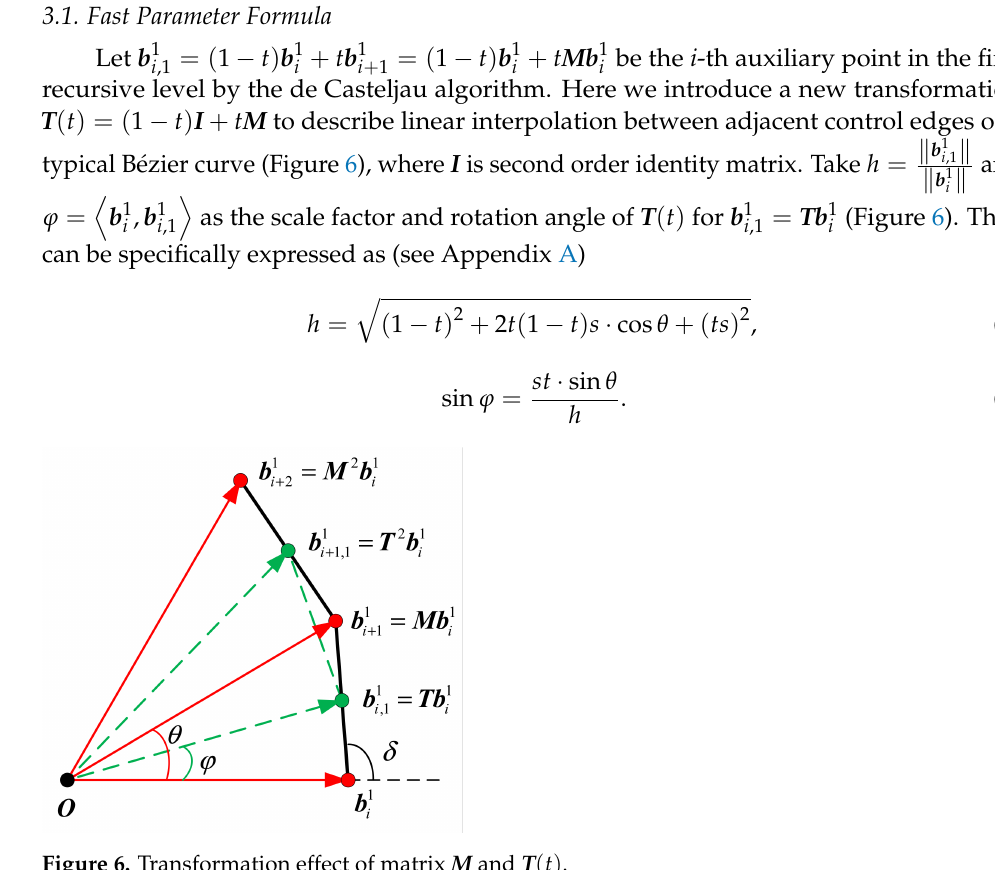
Figure 6. Transformation effect of matrix M and T ( t )